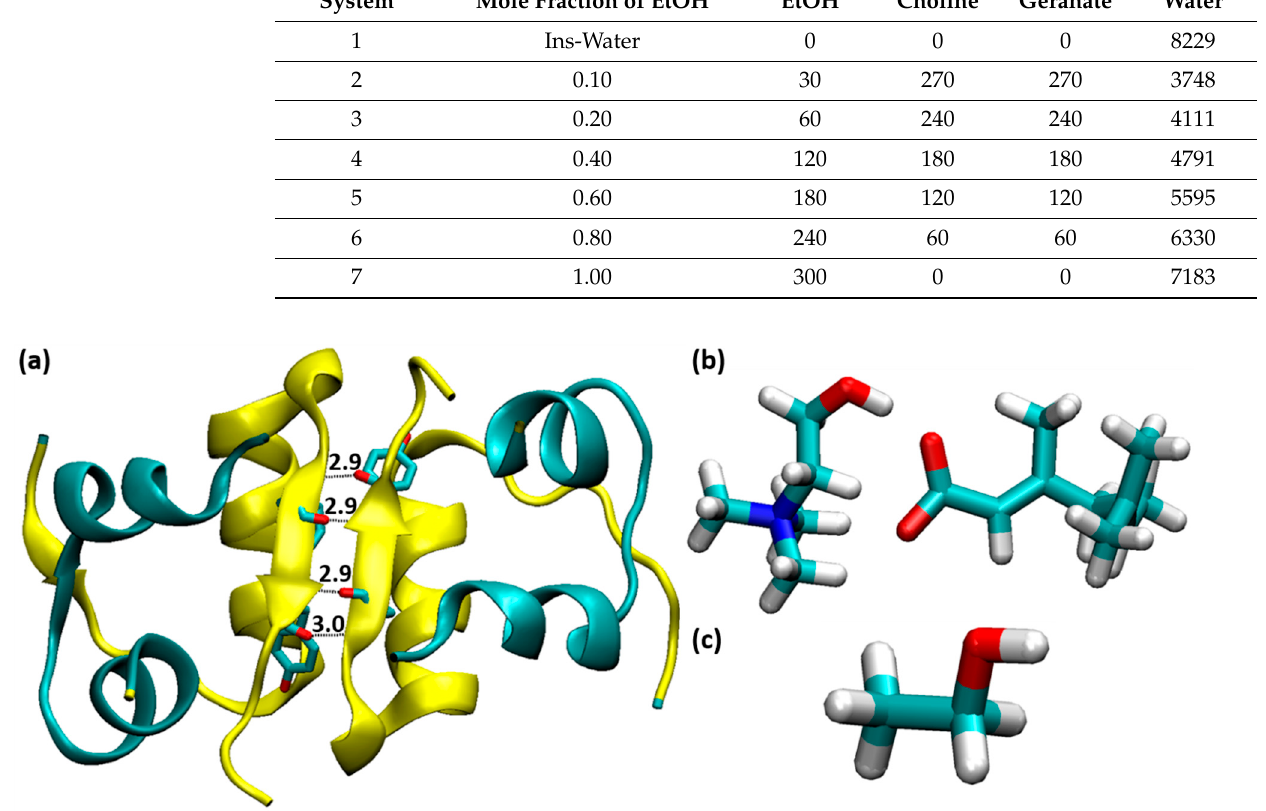
Table 1. The system details of mole fractions of CAGE and ethanol molecules.